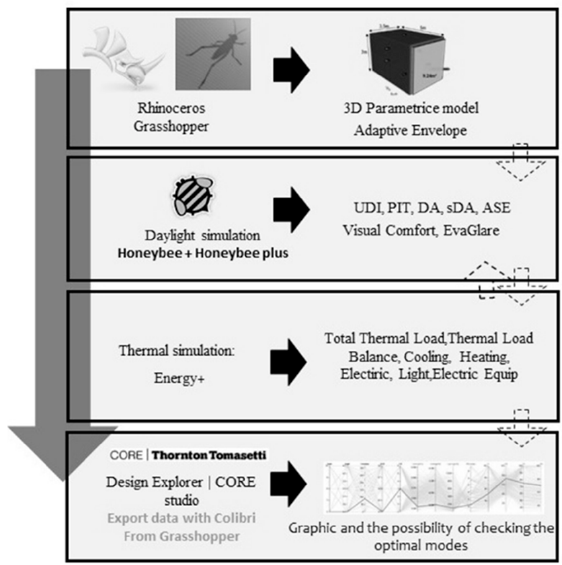
Figure 3. Simulation workflow.